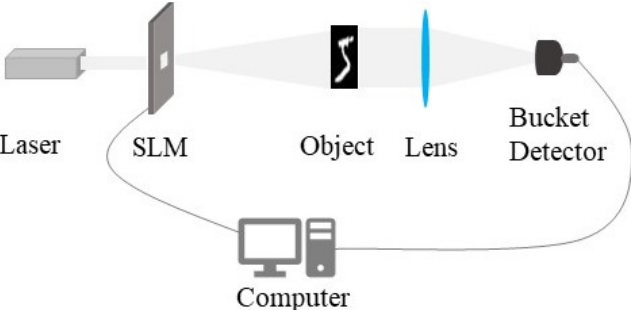
Figure 1. Diagrammatic sketch of computational ghost imaging.